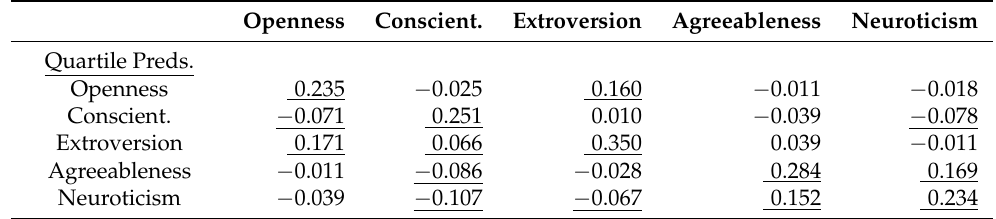
Table 8. Correlations between the gold-standard Big Five labels and predictions that use the quartile- delimited Big Five categories as features. Openness Conscient. Quartile Preds.